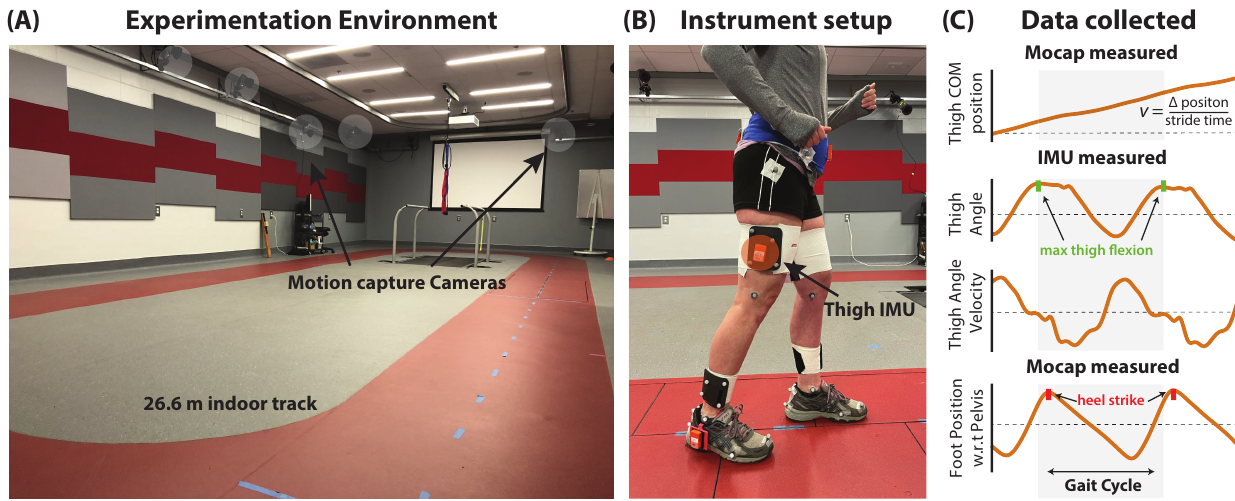
Figure 1. Study Overview: ( A ) Optical motion capture provided ground truth measurements. ( B ) A thigh inertial measurement unit (IMU) provided all data used for the IMU-based estimation. ( C ) Example motion capture (Mocap) and IMU measured data collected and used in the study. Abbreviations: IMU—inertial measurement unit, COM—center of mass; w.r.t—with respect